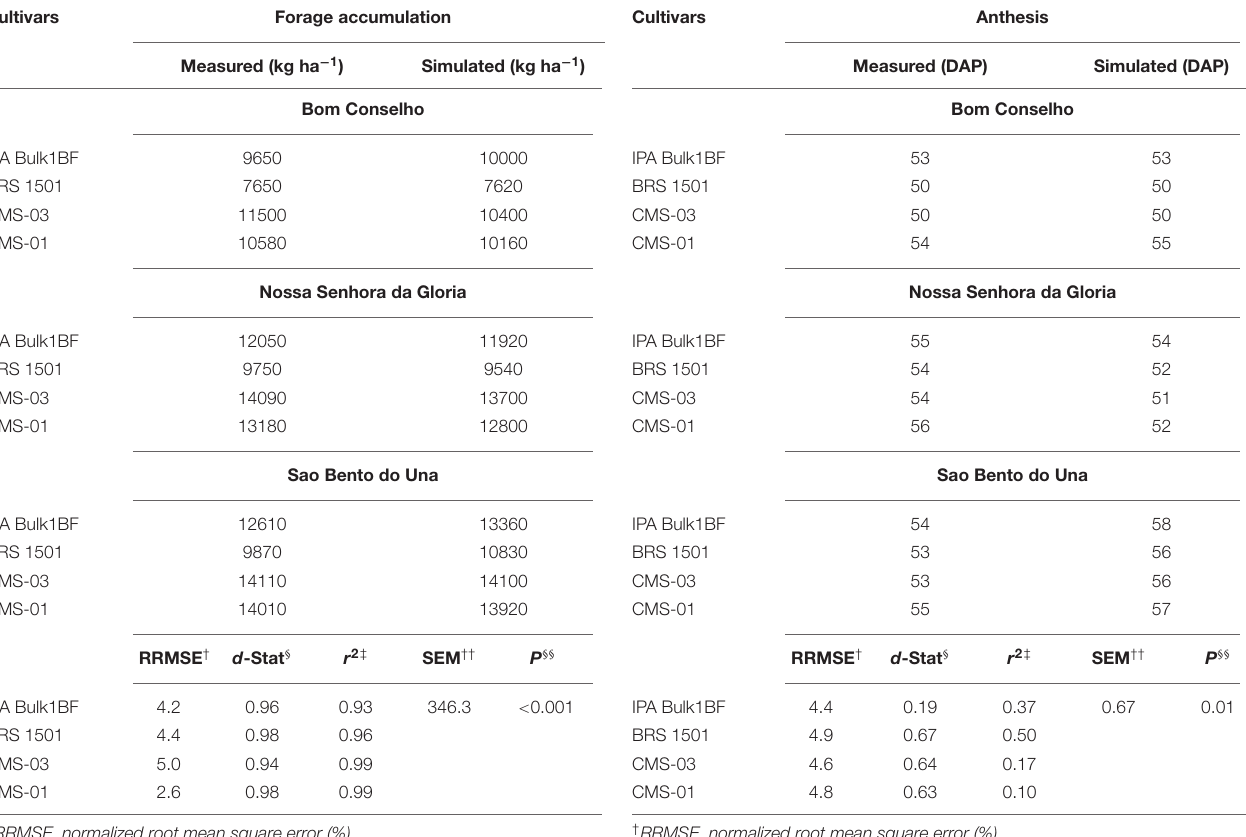
TABLE 4 | Anthesis date for pearl millet under rainfed conditions at three locations in Brazil, as measured and simulated after